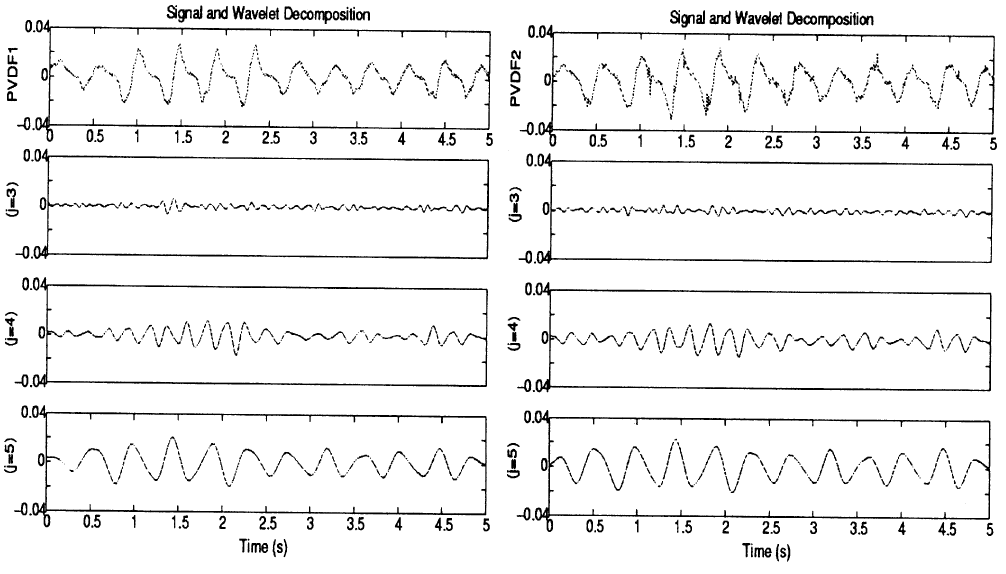
Fig. 16. An example of wavelet decompositions on prostate palpation